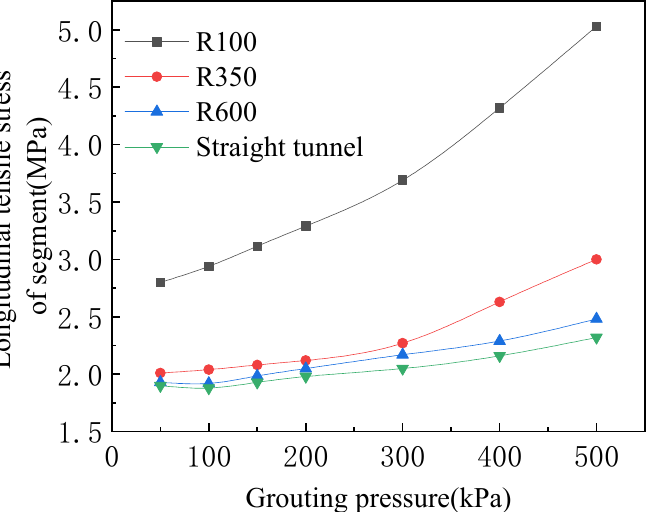
Figure 15. Variation curve of the maximum longitudinal tensile stress of the segment with the grouting pressure.